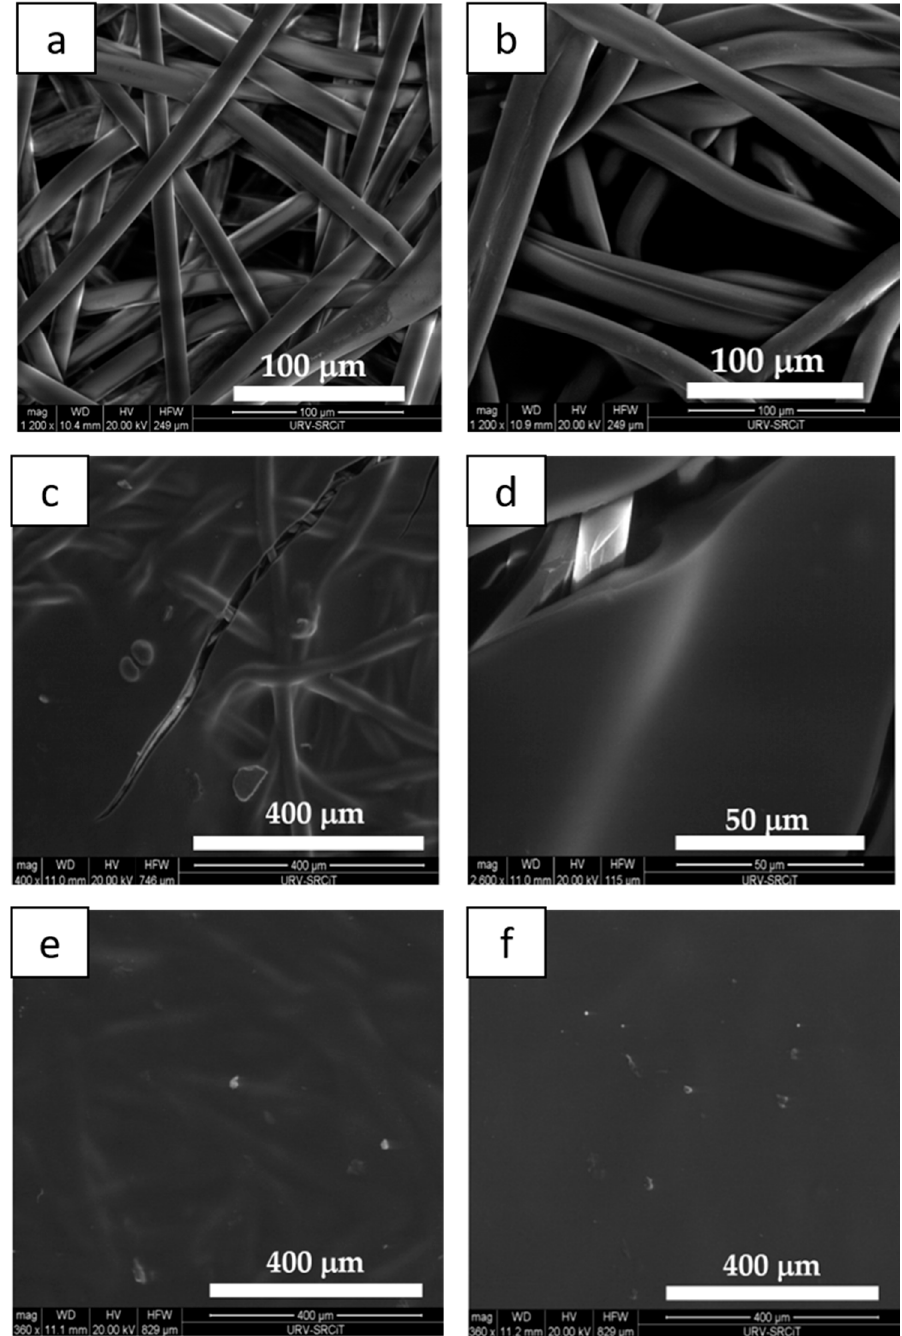
Figure 4. Environmental scanning electronic microscopy (ESEM) image of: a neat plaster ( a ); 1La sample ( b ); 2La sample ( c ) and its detail ( d ); 3La sample ( e ); 4La sample ( f ). and its detail ( d ); 3La sample ( e ); 4La sample ( f ). Table 1. Water static contact angles of neat plaster and samples 2LaW, 2La–4La.